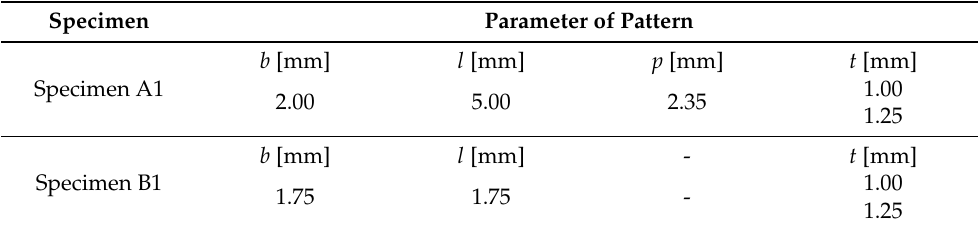
Table 2. Parameters of tested structures.